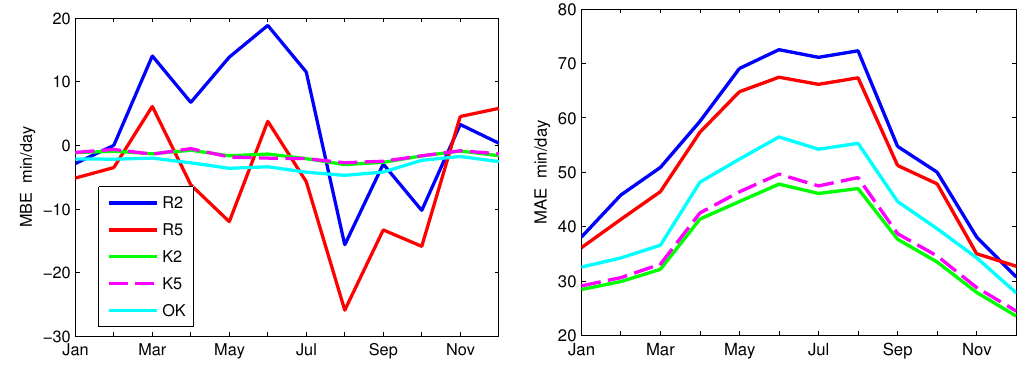
Figure 1. Cross-validation MBE (left panel) and MAE (right panel) for selected methods as a function of the